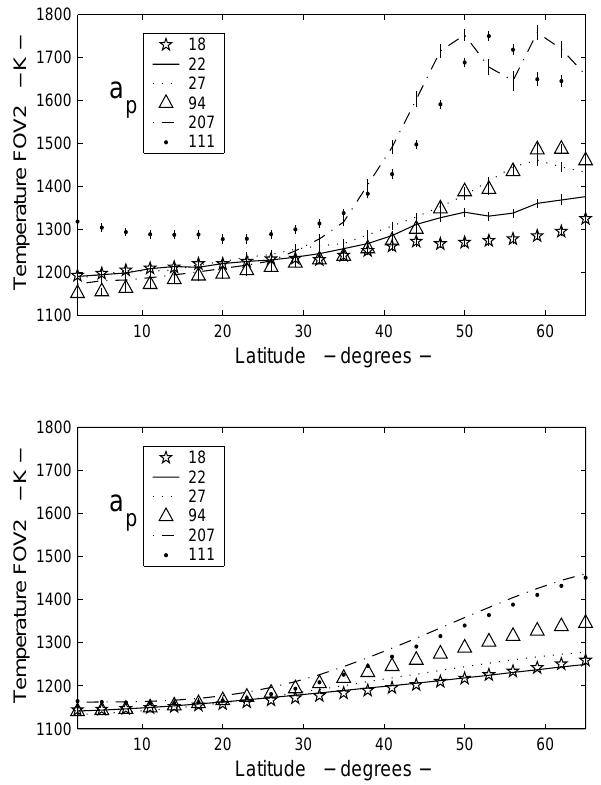
Fig. 8. Latitudinal/local time variations of the temperature for 6 or- bits on UARS day 168. The temperatures for the different orbits are represented by different symbols, as indicated on the figure with the corresponding magnetic indices. The upper panel shows WINDII O( 1 D) temperatures, while the bottom panel shows the MSIS-90 temperatures obtained at the same latitude/local time and for the same altitude range